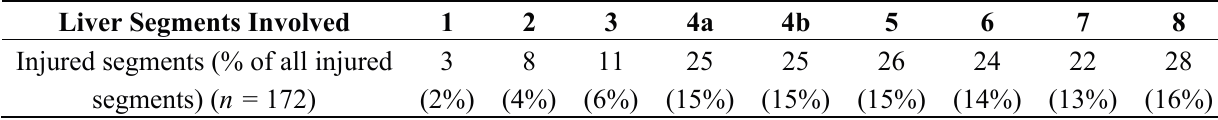
Table 3. Distribution of liver lesions for all patients defined by the Coineaud liver segments.